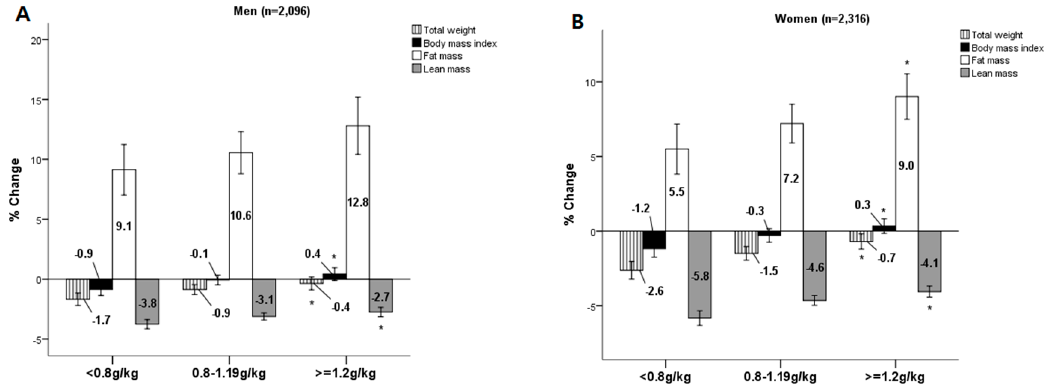
Figure 1. Change in body composition over 12 years by the levels of dietary protein intake at baselines. ( A ) men and ( B ) women. % Change = ((12-year follow-up value-baseline value) / baseline value × 100). ANOVA = analysis of variance. * Indicates significantly linear trend across the protein intake categories according to different recommendations: p for trend < 0.05.